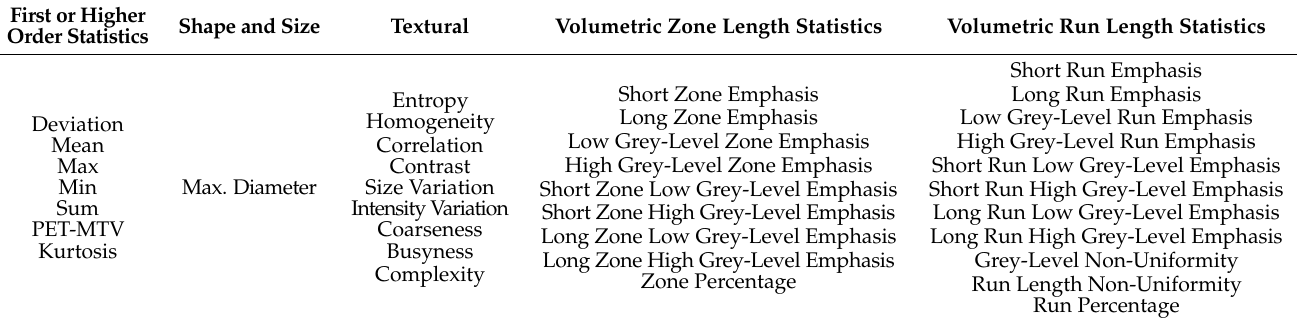
Table 1. List of the radiomics features from both positron emission tomography (PET) and computed tomography (CT) modalities. Please note that the metabolic tumor volume (MTV) is PET-specific.